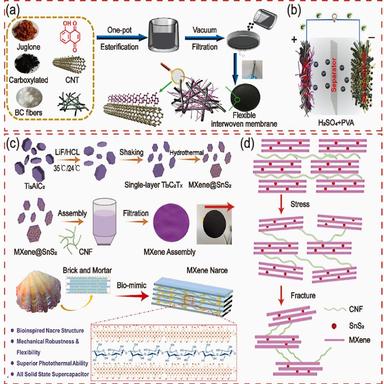
(a) Schematic illustration of the chemical bonding of juglone onto CNT and interweaving with BC fibers to prepare flexible interwoven electrodes. (b) Schematic illustration of device assembling. (c) Schematic illustration of the strategy for constructing bioinspired MXene nacre. (d) Idealized mechanism of mechanical reinforcement.